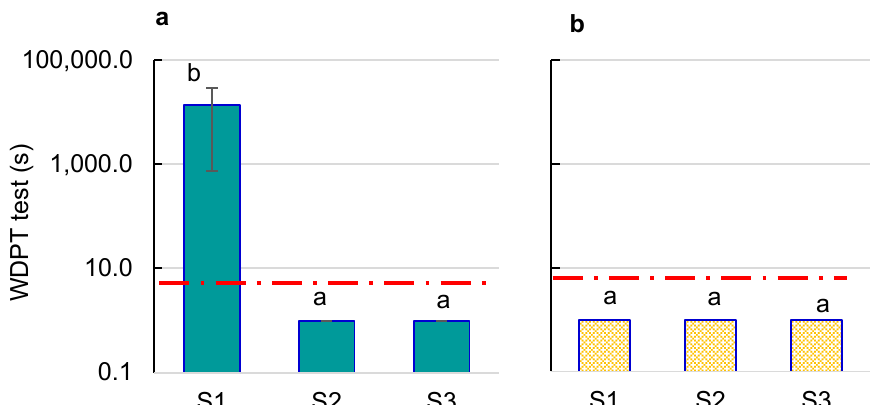
Figure 4. The median of the water drop penetration time (WDPT) test with upper and lower quartiles (range of quartiles is equal to 1 for all sites except S1, 0 ‒ 5 cm), as actual soil water repellency (SWR), on the three sites, in two soil depths of ( a ) 0–5 cm and ( b ) 35 ‒ 40 cm. Note: The red dashed line, WDPT = 5 s, is the boundary between wettable and water-repellent soil in the SWR classification (Dekker and Jungerius, 1990). Different letters denote significant differences between sites, as determined with the Kruskal–Wallis test ( α = 0.05).